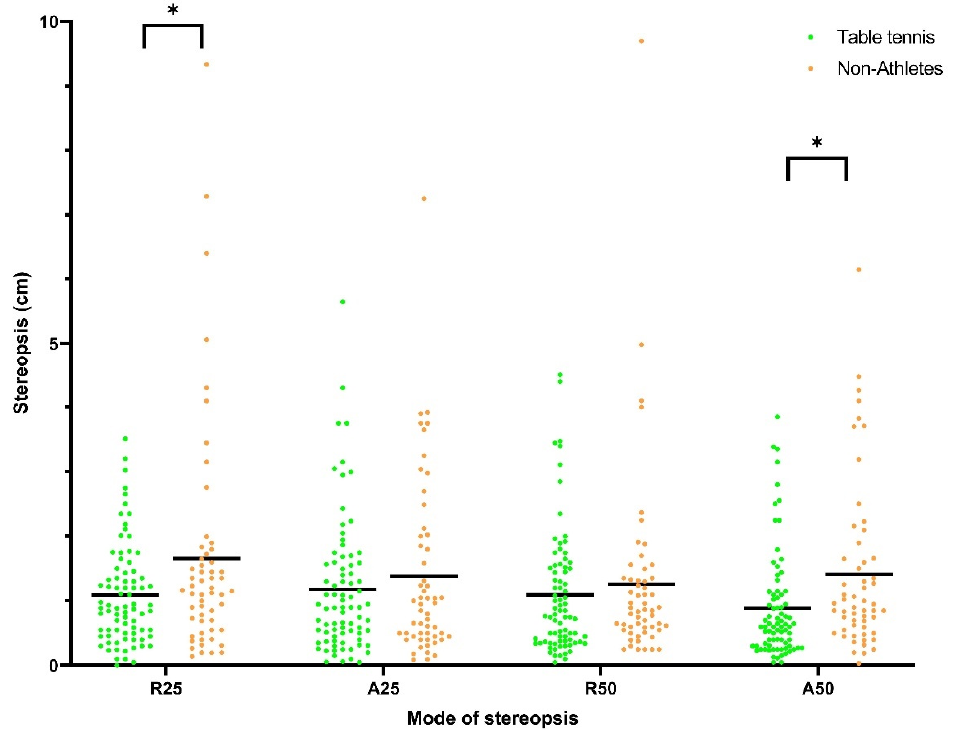
Figure 2. Stereopsis of table tennis athletes and non-athletes measured in four modes of stereopsis. (*: statistical significant between table tennis athletes and non-athletes)